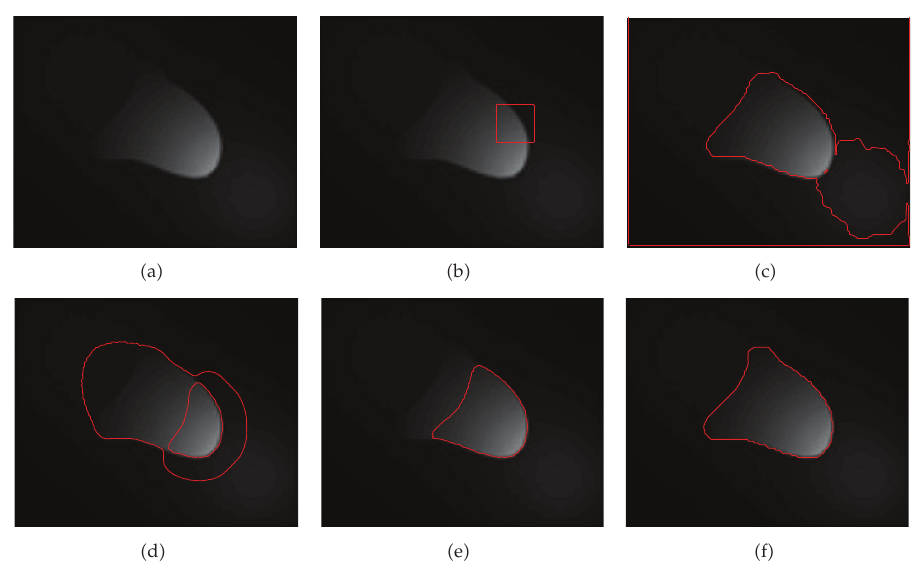
Figure 1: Results of an inhomogeneous image with di ff erent models. (cid:6) a (cid:7) The original image. (cid:6) b (cid:7) The initial contour. (cid:6) c (cid:7) The final contour with the CV model. (cid:6) d (cid:7) The final contour with the LBF model. (cid:6) e (cid:7) The final contour with the LGIF model. (cid:6) f (cid:7) The final contour with the proposed